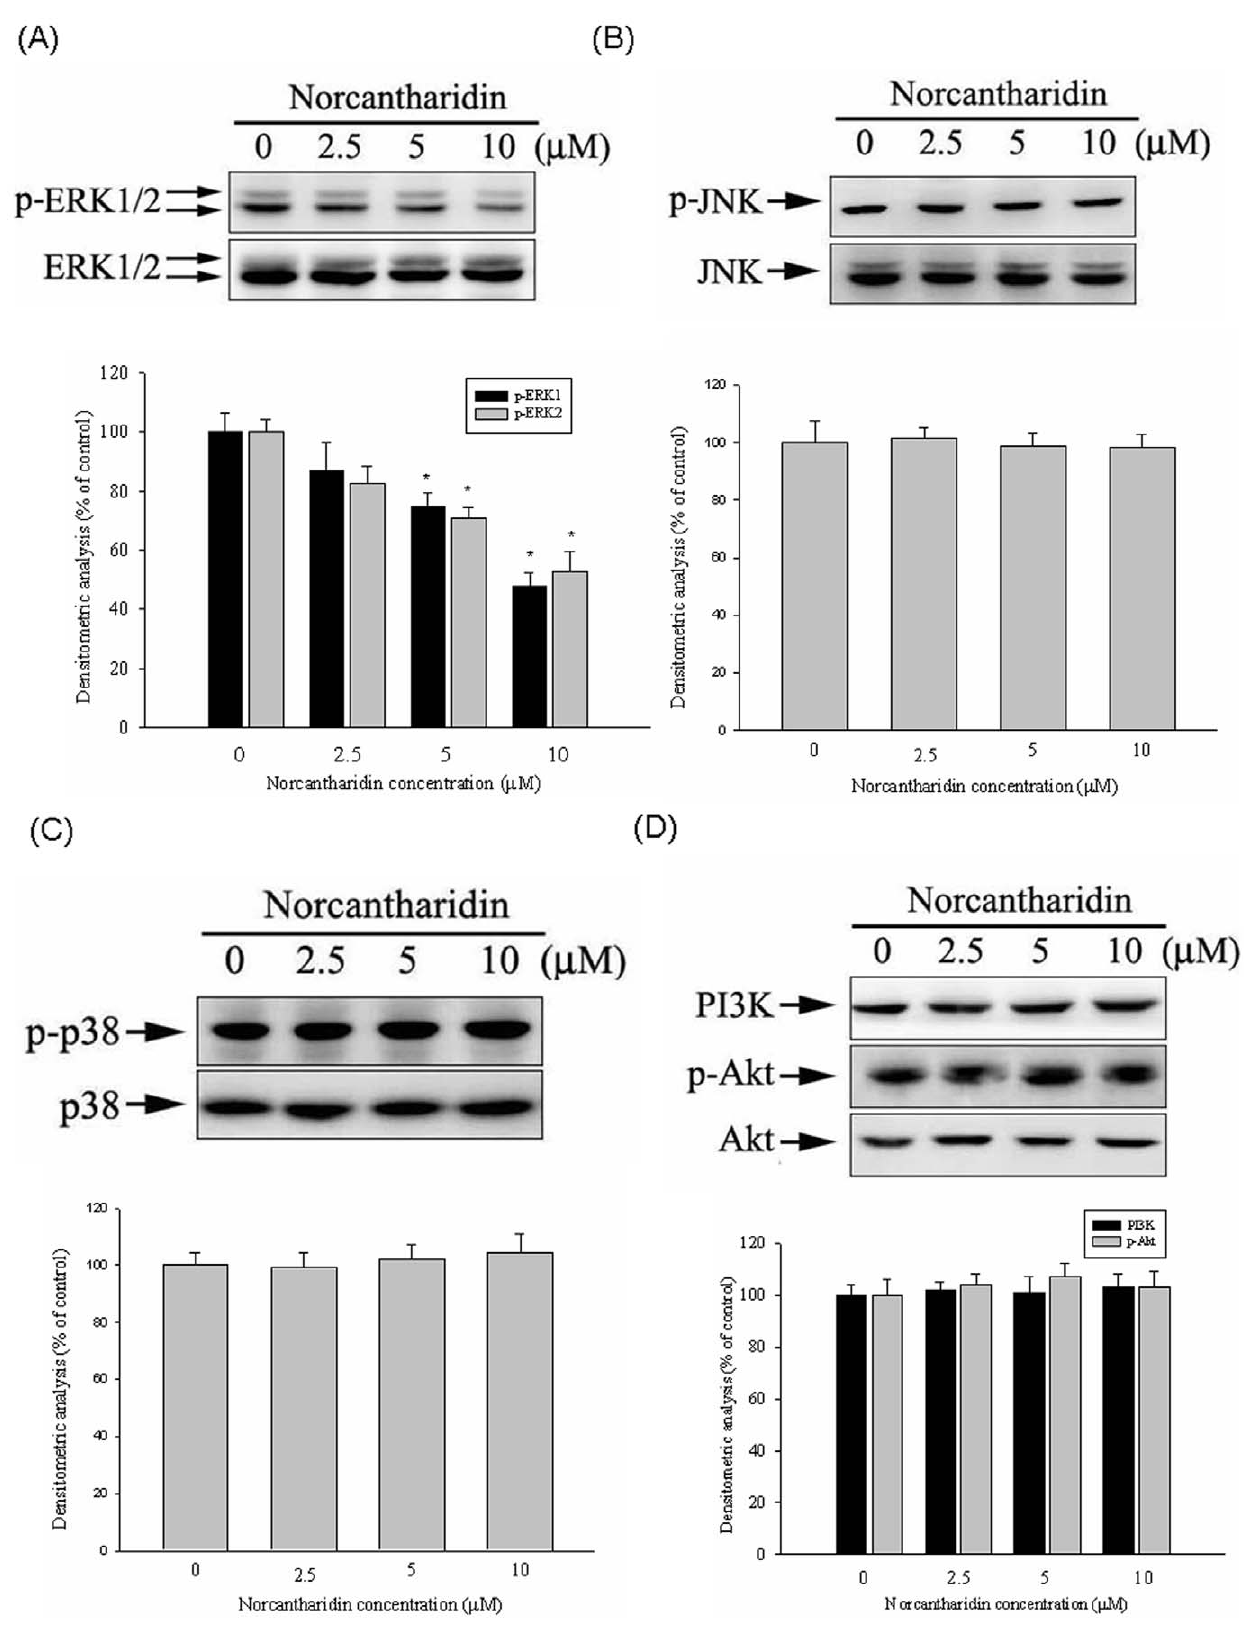
Figure 5. Effects of NCTD on the MAPKs pathway and PI3K/Akt signalings. Huh7 cells were cultured in various concentrations of NCTD (0, 2.5, 5, 10 m M) for 24 hours, and then the cell lysates were subjected to SDS–PAGE followed by western blots with (A) anti-ERK1/2, (B) anti-JNK, (C) anti-p38 and (D) anti-PI3K and anti-Akt (total and phosphorylated) antibodies as described in Materials and Methods. Determined activities of these PLoS ONE |